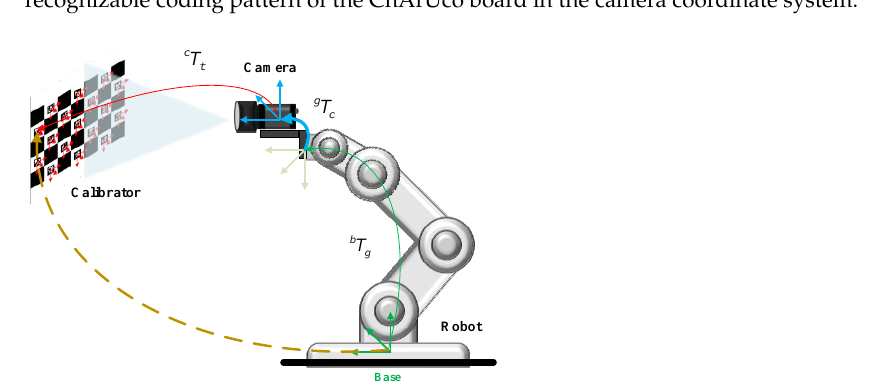
Figure 5. ( a ) The pose of the ArUco marker in the camera coordinate system; ( b ) The pose of each recognizable coding pattern of the ChArUco board in the camera coordinate system.